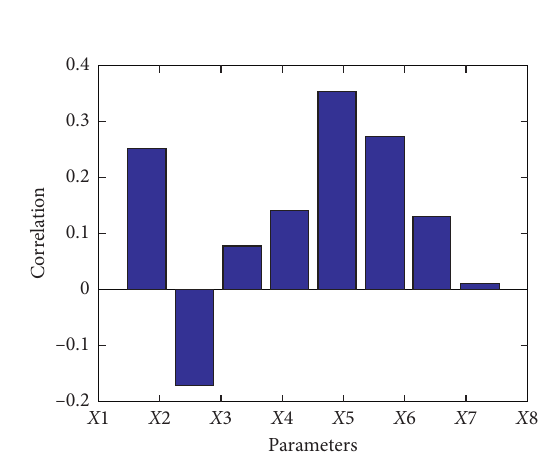
Figure 10: Effect of parameters on debonding strain.